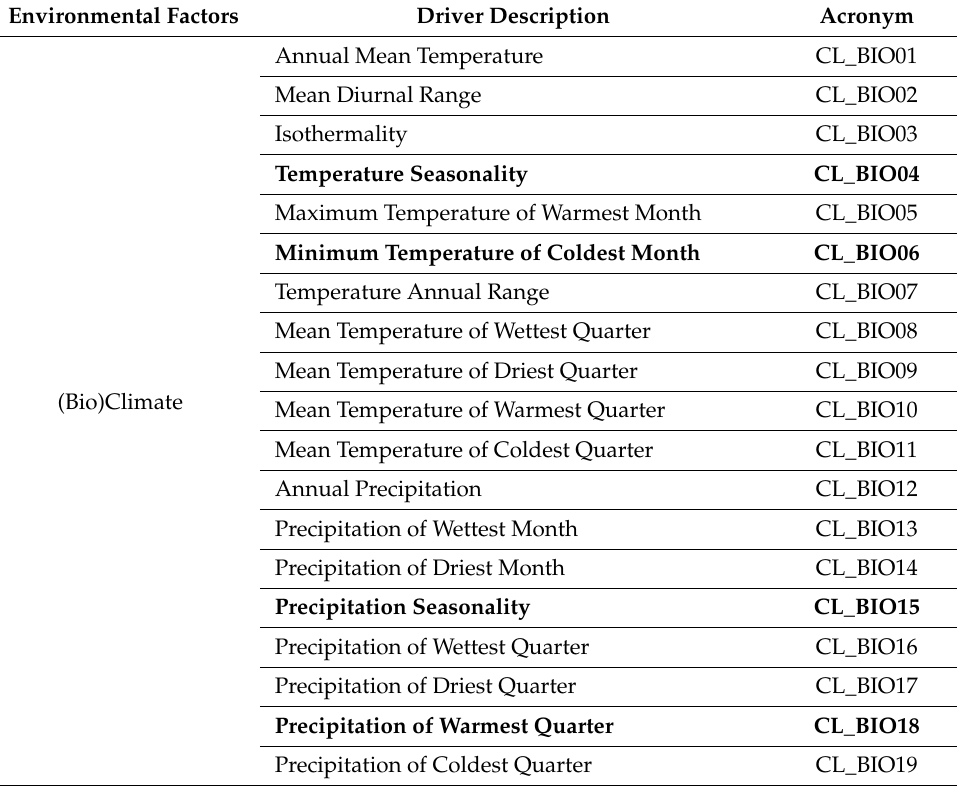
Table 2. Full list of environmental factors considered, which were hypothesized as drivers of invasion in the study area, totaling 59 independent variables (see also Appendix B). Variables in bold were selected for the final RF regression model ( n =